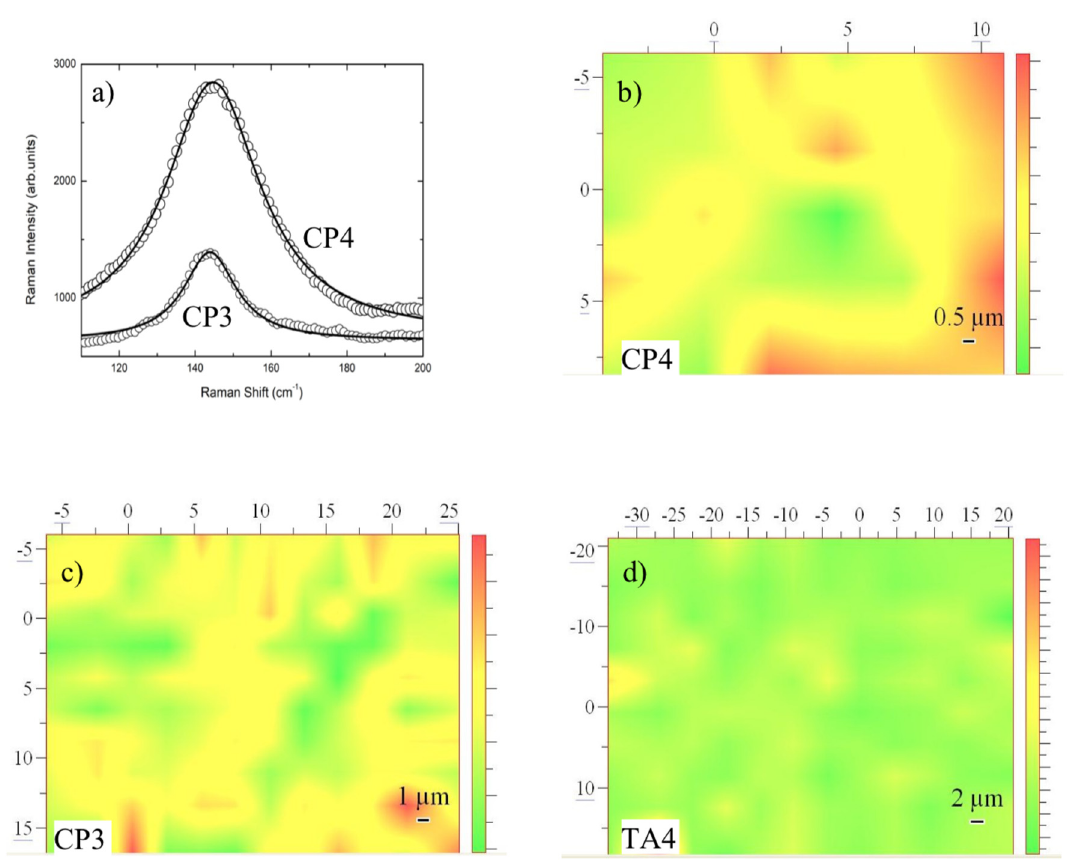
Figure 4. ( a ) Raman spectra in the region 100–200 cm − 1 for CP3 and CP4 samples (open circle) and the best fitting results (solid lines). The integrated intensities from best fitting procedures have been used to obtain: ( b ) Raman mapping of a region of 15 × 15 µ m 2 of CP4; ( c ) Raman mapping of a region of 32 × 22 µ m 2 of CP3; ( d ) Raman mapping of a region of 55 × 40 µ m 2 of TA4 .